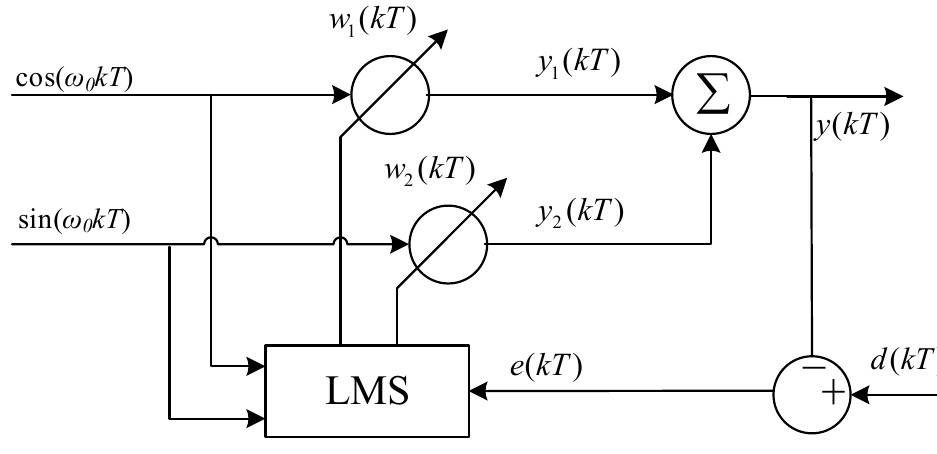
Figure 3. LMS adaptive filtering principle .